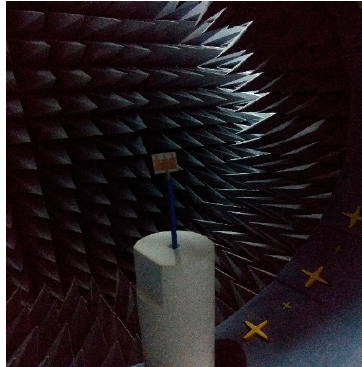
Figure 14. Satimo setup of the fabricated